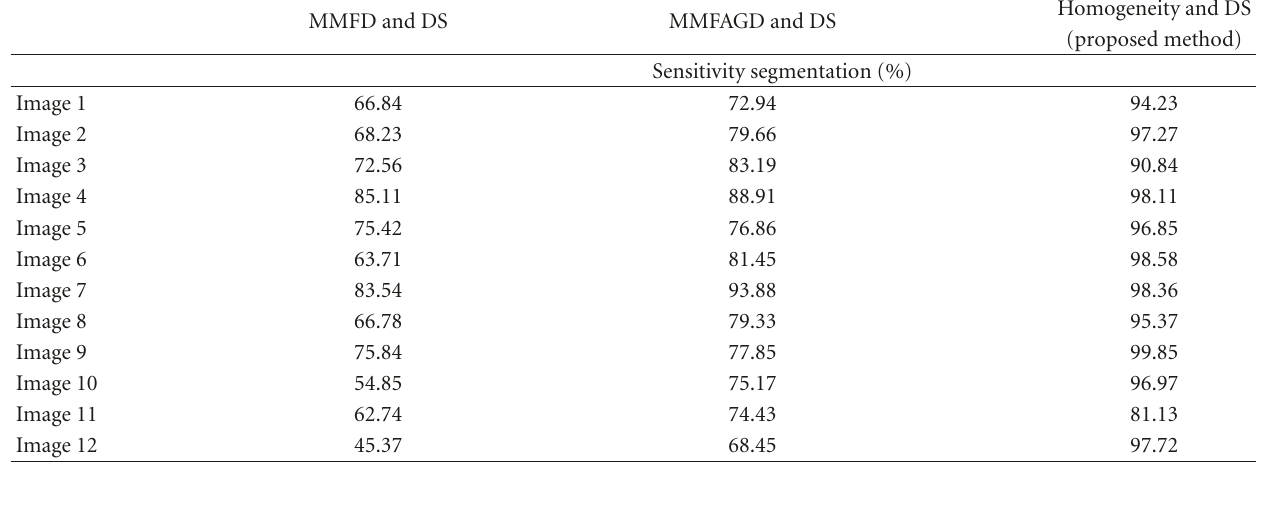
Table 1: Segmentation sensitivity from MMFD and DS, MMFAGD and DS and homogeneity method and DS for the data set shown in Figure 5. MMFD and DS MMFAGD and DS